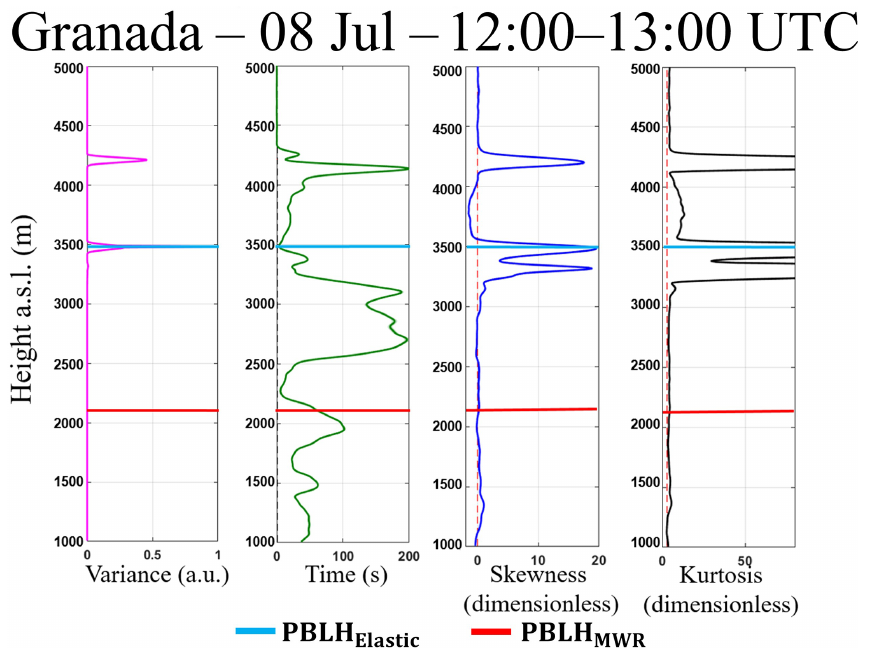
Figure 19. Statistical moments obtained from 1064nm wavelength data of elastic lidar (MULHACÉN) in Granada from 12:00–13:00UTC on 8 July 2016. From left to right is the variance ( σ 2 ), integral timescale ( τ RCS (cid:48) ), skewness ( S RCS (cid:48) ) and kurtosis ( K RCS (cid:48) RCS (cid:48)